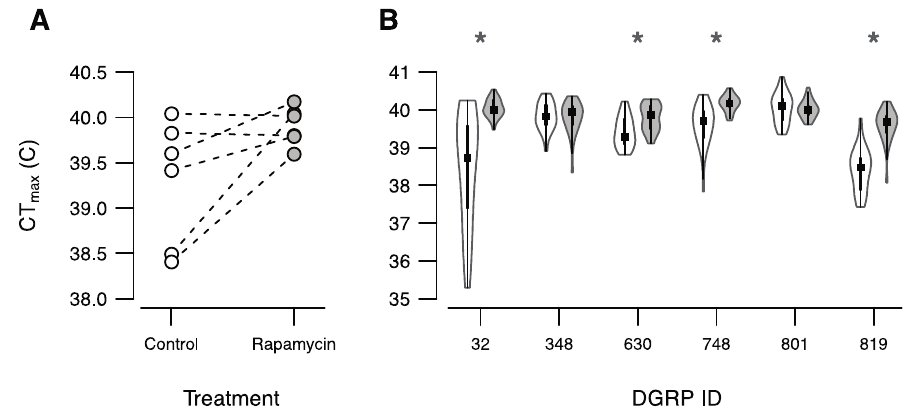
Figure 1. Effects of rapamycin treatment on male D. melanogaster CT max . ( A ) Interaction plot of DGRP genotypes across the two treatments. Points represent within line and treatment means. ( B ) Violin plots showing the distribution of heat knockdown temperature. Each violin represents the distribution of data with a boxplot inside where the median is indicated by a black square. Significant difference in heat knockdown temperature within lines are indicated with asterisks ( p -value < 0.05).